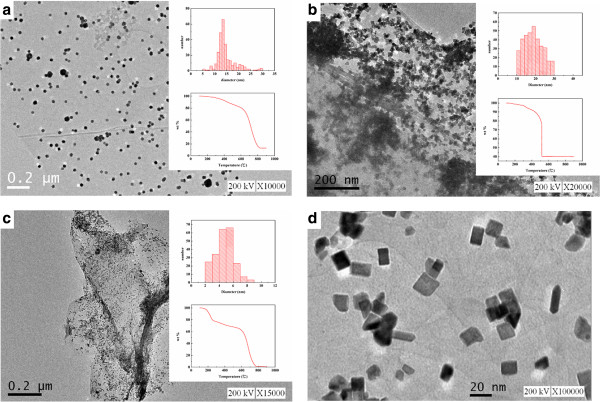
The TEM morphologies of the nanocomposites. (a) Entry 1, 12 wt.% Pt loading on graphene, (b) entry 2, 40 wt.% Pt loading on graphite oxide, and (c) entry 3, 14 wt.% Pt loading on graphite oxide, (d) cube-like morphology of entry 2 with × 100,000 magnification. The upper intersectional images are the particle size distributions, and the lower intersectional images are the TGA results.